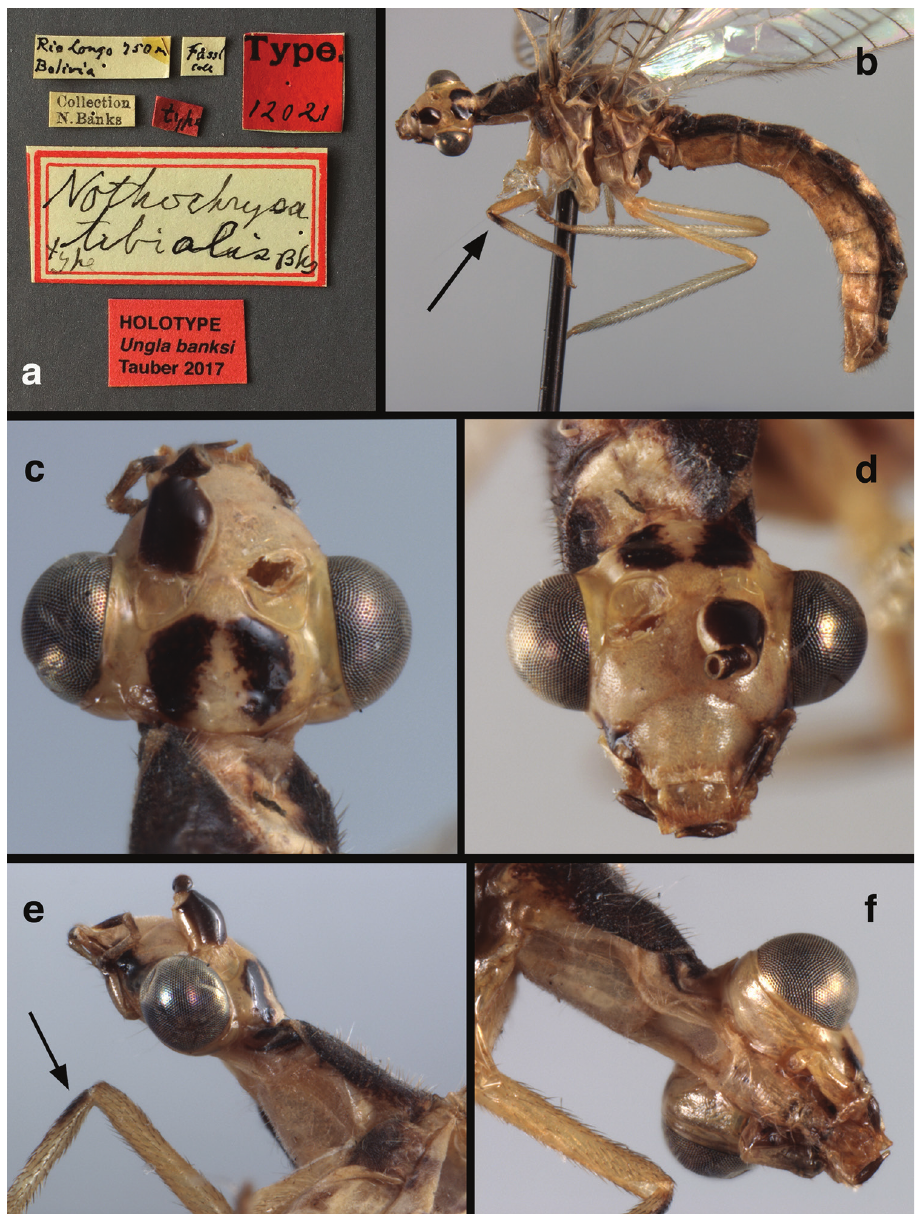
Figure 11. Ungla banksi Tauber, new replacement name: External features, ( a ) labels ( b ) habitus, lateral ( c ) head, dorsal ( d ) head, frontal ( e ) head, prothorax, lateral ( f ) head, prothorax, ventral. Arrows indicate dark, foretibial spot (Bolivia, Rio Zongo, holotype, male,